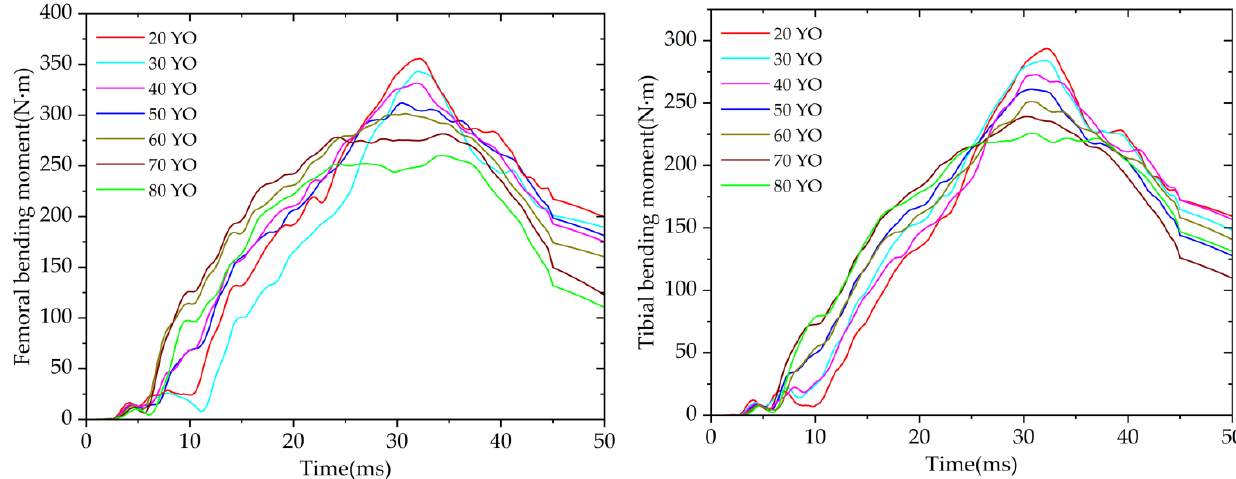
Figure A4. Bending moment of femur and tibia of pedestrians of seven ages at 60 km/h.